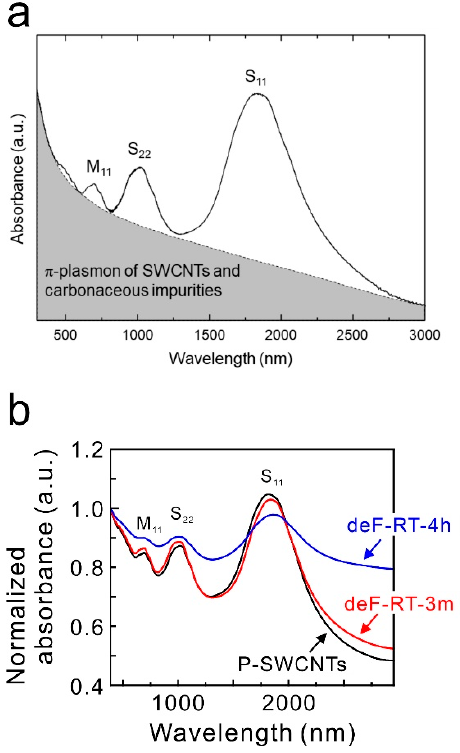
Figure 9. ( a ) Visible/near-infrared (Vis-NIR) spectrum of typical SWCNTs synthesized by the arc discharge method. ( b ) Vis-NIR spectra of P-SWCNTs, deF-RT-3m, and deF-RT-4h. Table 4. Percentage of metallic nanotubes in each sample.